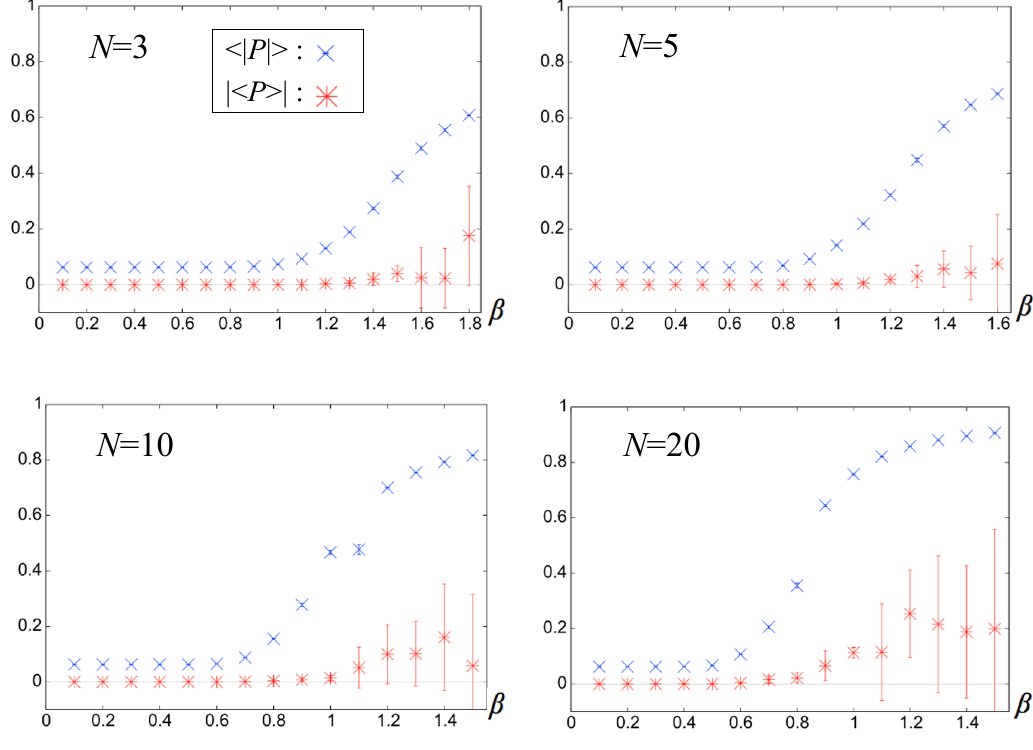
Figure 1 . Expectation values of the Polyakov loop for N = 3 ; 5 ; 10 ; 20 with ( N s ; N (cid:28) ) = (200 ; 8) with Z N -TBC. Red points indicate jh P ij while blue points hj P ji . For low (cid:12) , jh P ij (red points)